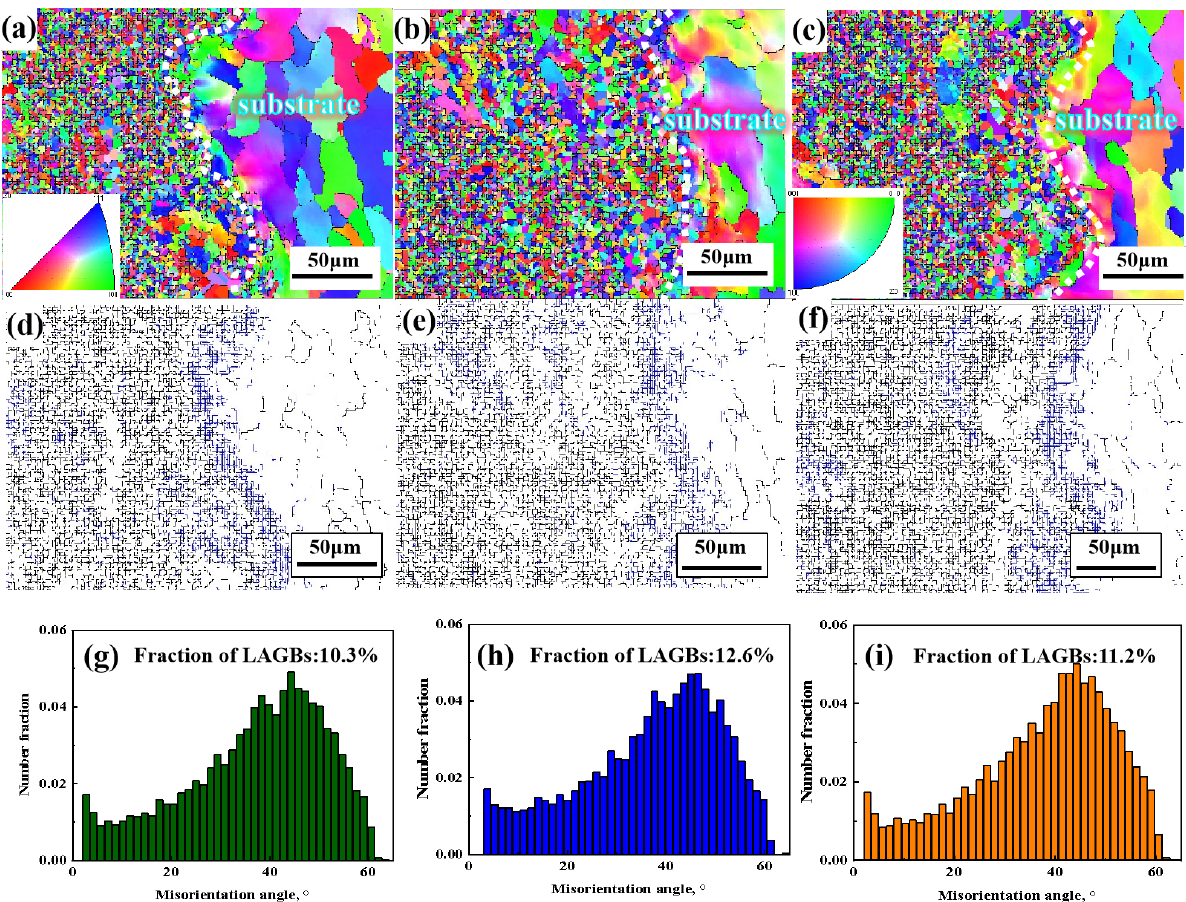
Figure 3. IPF maps, distinguishing grain boundary distribution and fraction of LAGBs of the coat- ings, respectively: ( a , d , g ) Fe-based coating, ( b , e , h ) 9% γ -Fe coating, ( c , f , i ) 9% γ -Fe coating. The porosity quantity of the coatings is measured in Figure 4. The cross-section mor- phology of coatings was captured in fi ve SEM pictures at 800× magni fi cation, which was utilized to determine the average porosity value. Based on the picture analysis, the poros- ity measurement was assessed. In the end, the porosity values for 6% γ -Fe coating and 9% γ -Fe coating were 1.02% and 0.93%, respectively, which is much less than that of Fe-based coating (3.97%).